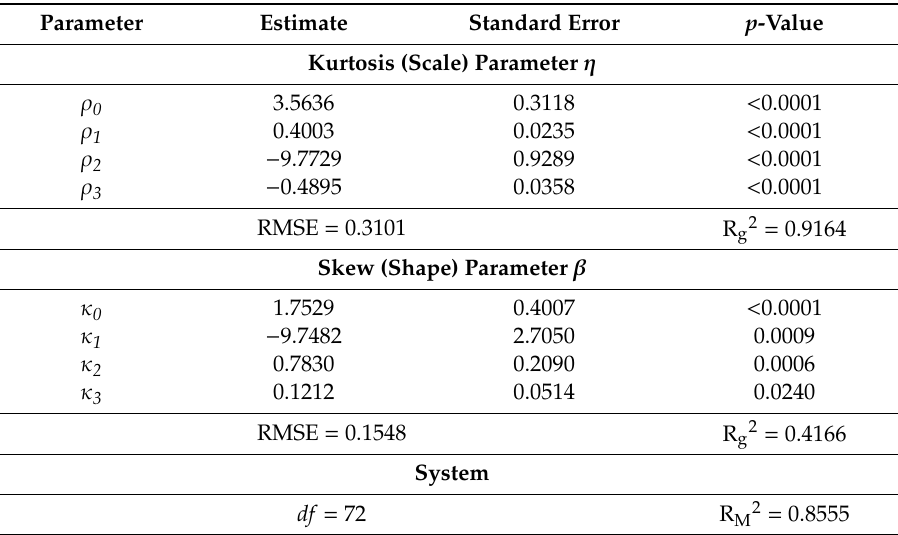
Table 6. Parameters, estimates, standard errors, p -values, and fit statistics for the models predicting EM-estimates (see text) of tree-level, right-truncated Weibull parameters η (Equation (11)) and β (Equation (12)) fitted by iterative three-stage least squares